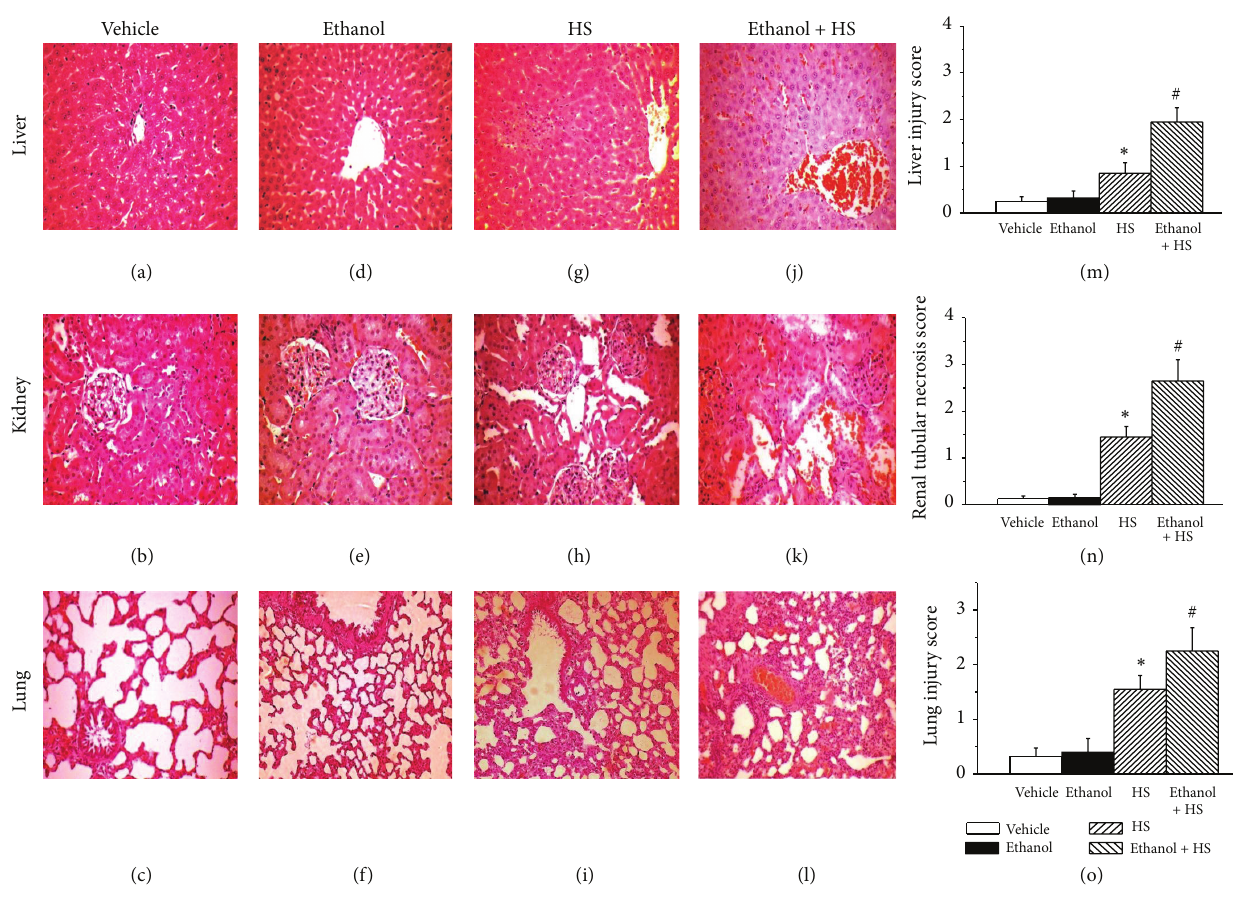
Figure 7: Histopathologic changes in the liver, kidneys, and lung after hemorrhagic shock in rats. Histologic sections from the Vehicle group ((a), (b), (c)), Ethanol group ((d), (e), and (f)), HS group ((g), (h), and (i)), and Ethanol + HS group ((j), (k), and (l)), stained with hematoxylin and eosin (liver, kidneys, lungs: magnification × 200). Photomicrographs (a), (d), (g), and (j) are liver sections; (b), (e), (h), and (k) are kidney sections; (c), (f), (i), and (l) are lung sections. Histopathologic injury score in liver (m), kidney (n), and lung (o) after hemorrhagic shock in rats. ∗ 𝑃 < 0.05 for the HS group compared with the Vehicle group. # 𝑃 < 0.05 for the Ethanol + HS group compared with the HS